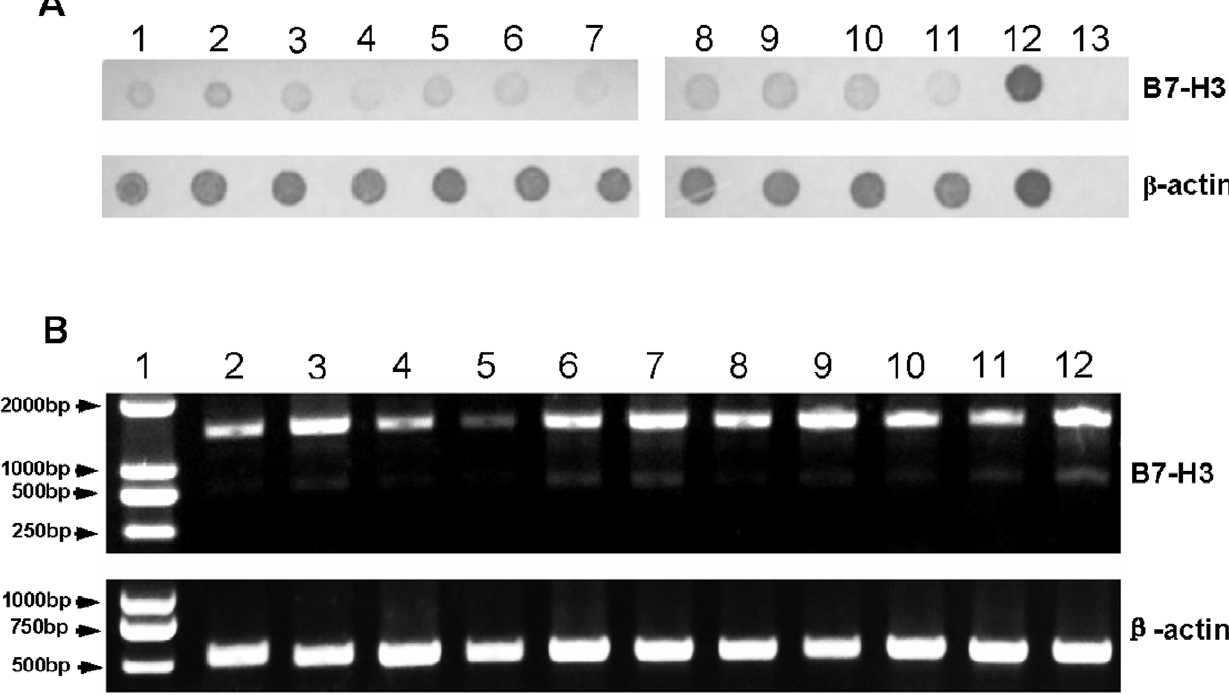
Figure 2. Distribution and analysis of the porcine B7-H3. A, Dot-blot hybridization assay of mRNA from different tissues using the probes of 4Ig- B7-H3. Samples of PBMCs, PAM, heart, liver, spleen, lung, kidney, brain, lymph nodes, small intestine, tonsil were loaded from dot 1 to 11, respectively, with positive control (dot 12) and negative control (dot 13). The upper and lower panels were B7-H3 and b -actin, respectively. B, Analysis of the porcine B7-H3 isoforms. The normalized PCR products of PBMCs, PAM, heart, liver, spleen, lung, kidney, brain, lymph nodes, small intestine, tonsil were loaded from lane 2 to 12 with DNA ladder marker (lane 1). The upper and lower panels were the PCR products of B7-H3 and b -actin, respectively.